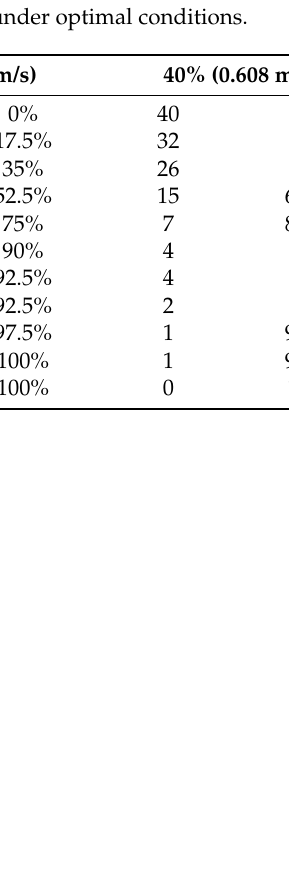
Figure 24. Particle emission effect curves of different inlet flow rates.